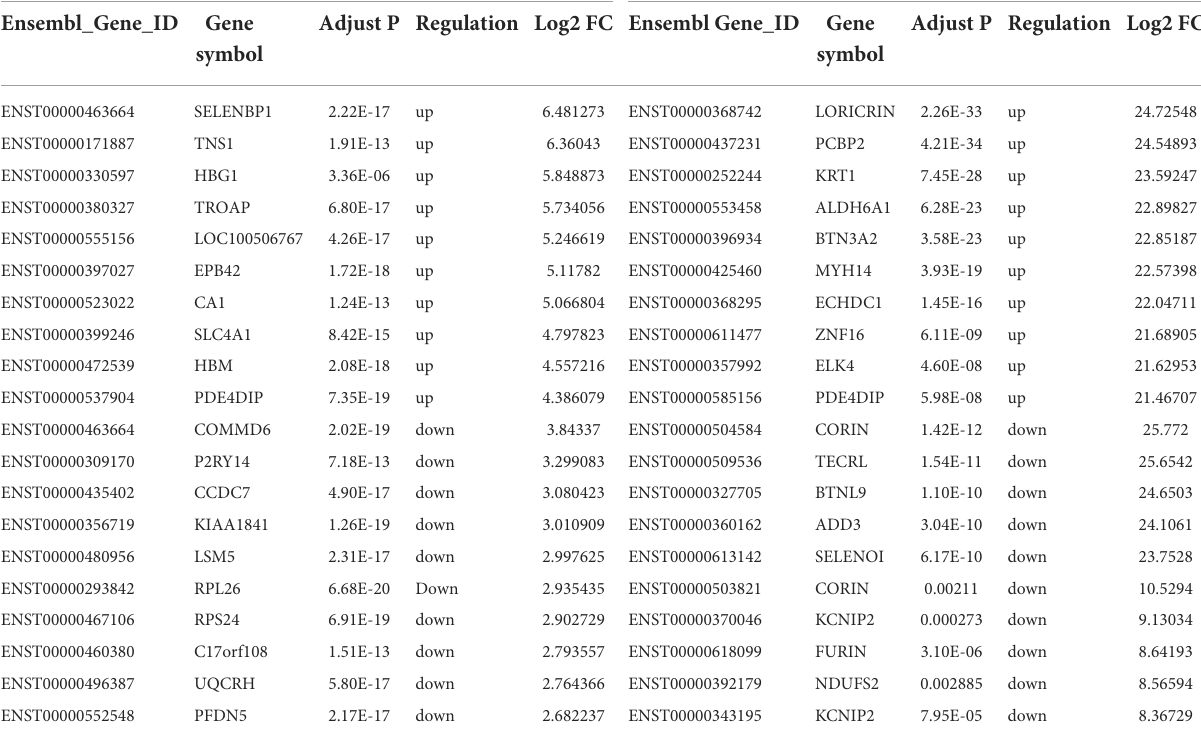
TABLE 2 Top 10 upregulated and downregulated mRNAs in the myocardial tissues of patients with HCM in GSE68316 and